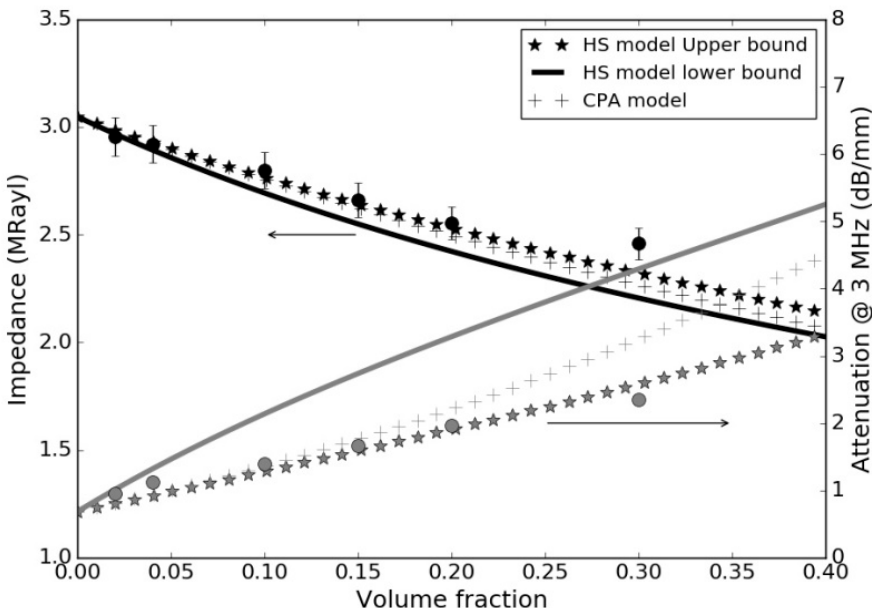
Figure 5. Variation in the impedance (black) and the ultrasonic attenuation coefficient at 3 MHz (gray) with the rubber volume fraction in the rubber-loaded epoxy composites. Circles: experimental measurements. Solid line: HS model, lower bound; Starts: HS, upper bound, +: CPA model.